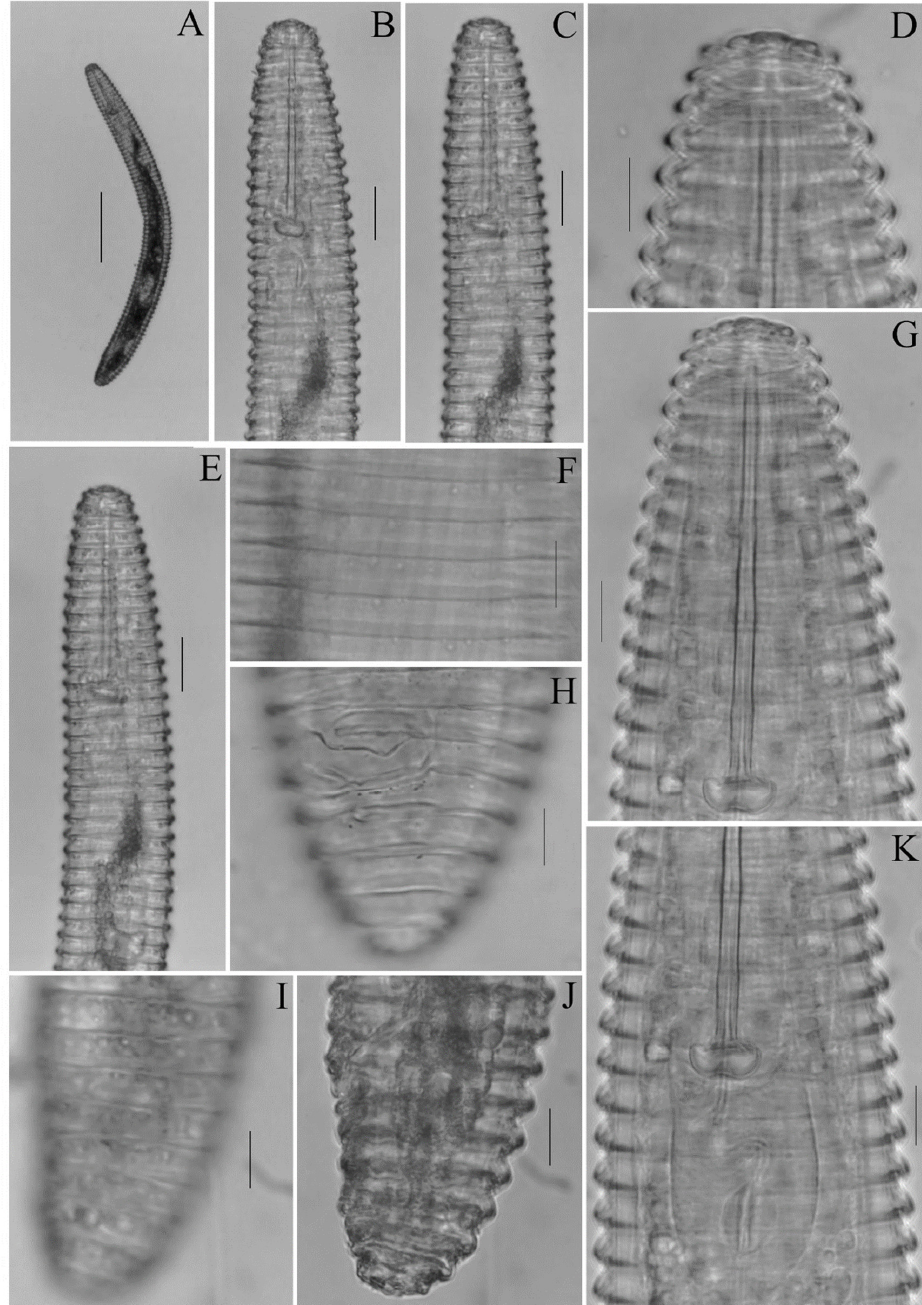
Figure 3. Diagnostic characters in the females of Mesocriconema xenoplax . ( A ): Total body; ( B , C ): details of the anterior end stylet and pharyngeal region; ( D , G ): head with small sub-median lobes; ( H – J ): posterior end, vulva, and tail region; ( F ): surface margins; and ( K ): pharyngal region. (Scale bars: ( A – C , E ) = 100 µm; ( D , F – K ) = 20 µm).